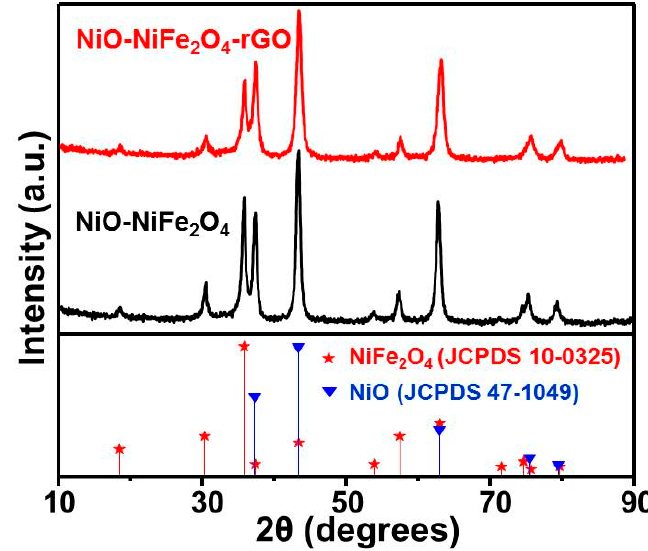
Figure 1. X-ray diffraction (XRD) pattern of NiO-NiFe 2 O 4 and NiO-NiFe 2 O 4 -rGO.